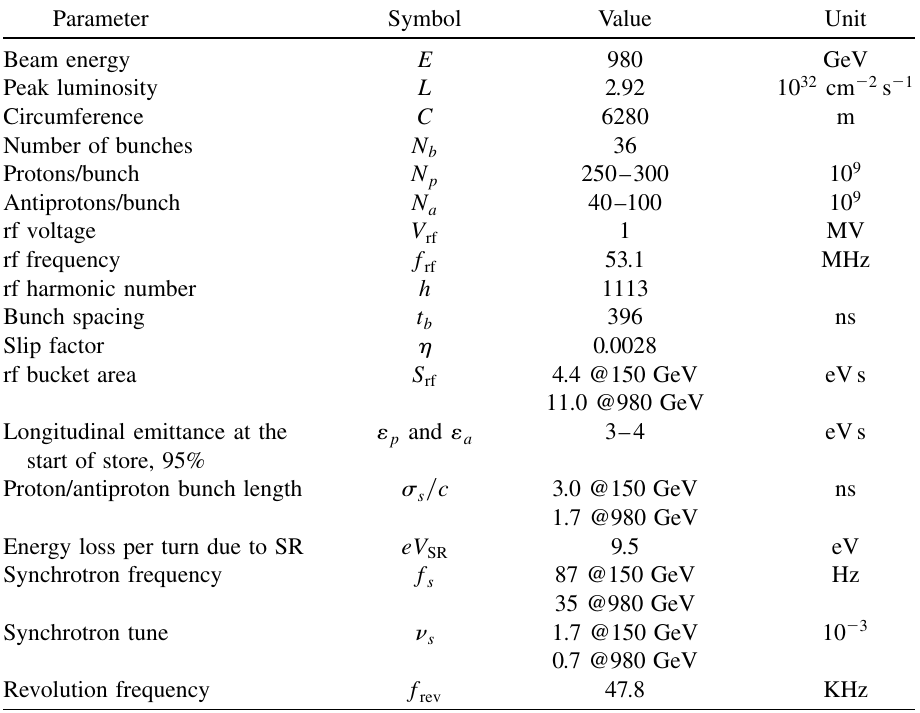
TABLE I. Tevatron collider run II